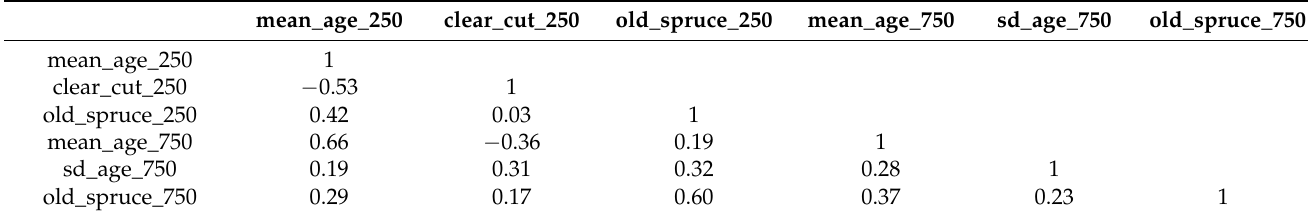
Table A2. Correlation among habitat characteristics included in occupancy